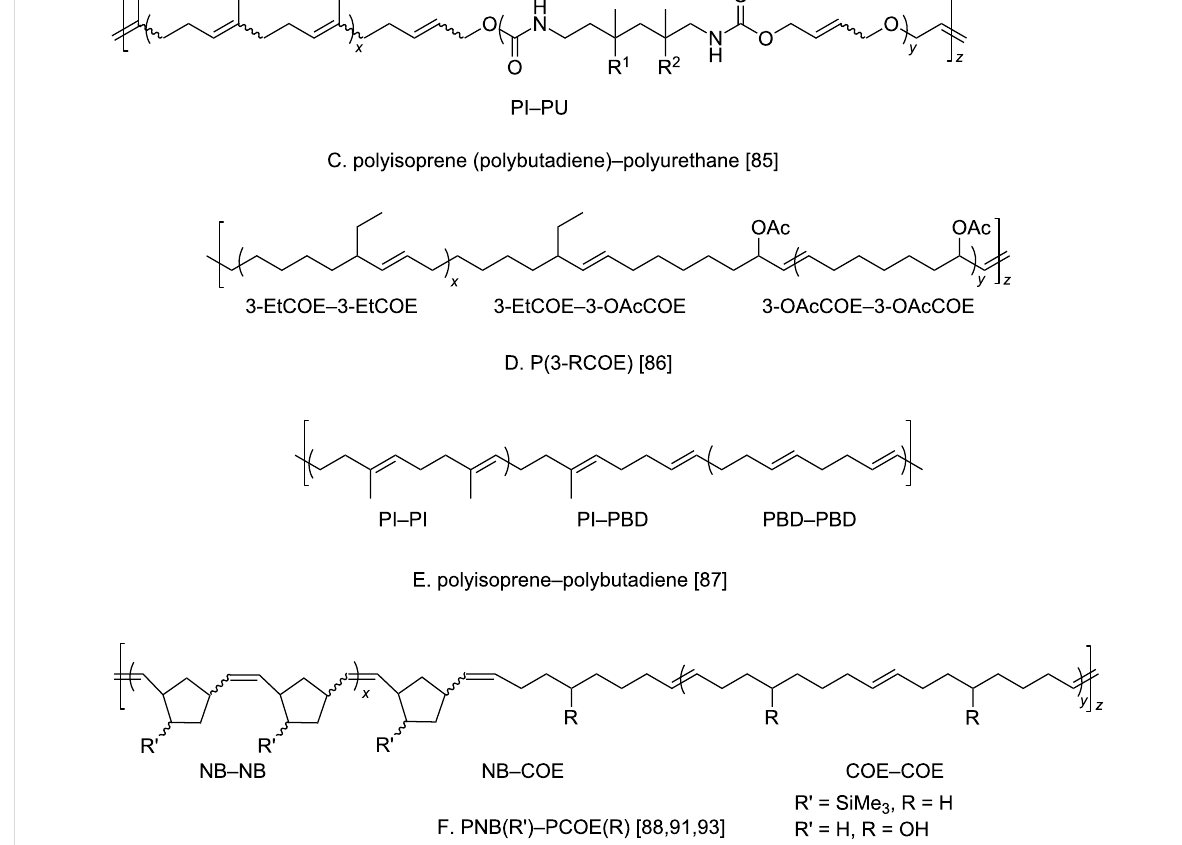
Figure 4: Multiblock copolymers synthesized by macromolecular cross